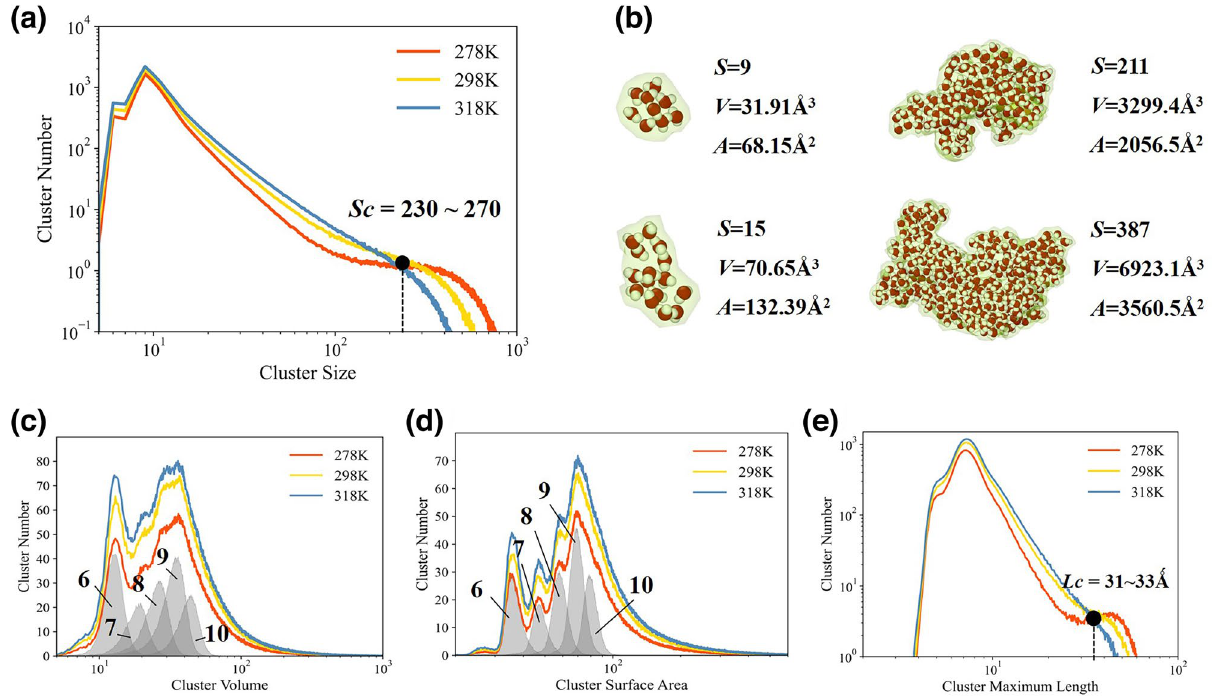
Figure 1. The cluster distributions and morphologies at various temperatures. ( a ) Water cluster distributions at 278 K, 298 K and 318 K. The black point denotes an isobestic point at S c = 230–270. ( b ) Various water cluster morphologies at time step 0 at 278 K drawn by Ovito 58 . S denotes cluster size. V and A denote the volume and surface area of the alpha shape of clusters. ( c ) The volume distributions of water cluster at 278 K, 298 K and 318 K. The gray zones represent volume distributions of clusters with 6–10 molecules. ( d ) The surface area distributions of water cluster at 278 K, 298 K and 318 K. The gray zones also represent surface area distributions of clusters with 6–10 molecules. ( e ) The maximum length distributions of clusters at 278 K, 298 K and 318 K. The black point denotes an isosbestic point at L c =